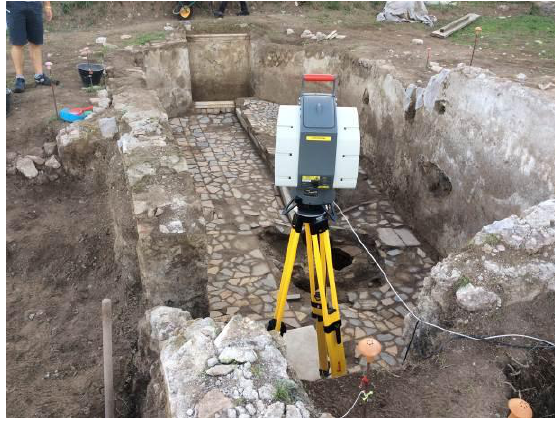
Fig. 3. TLS Scan Station, Ostia Antica, Italy